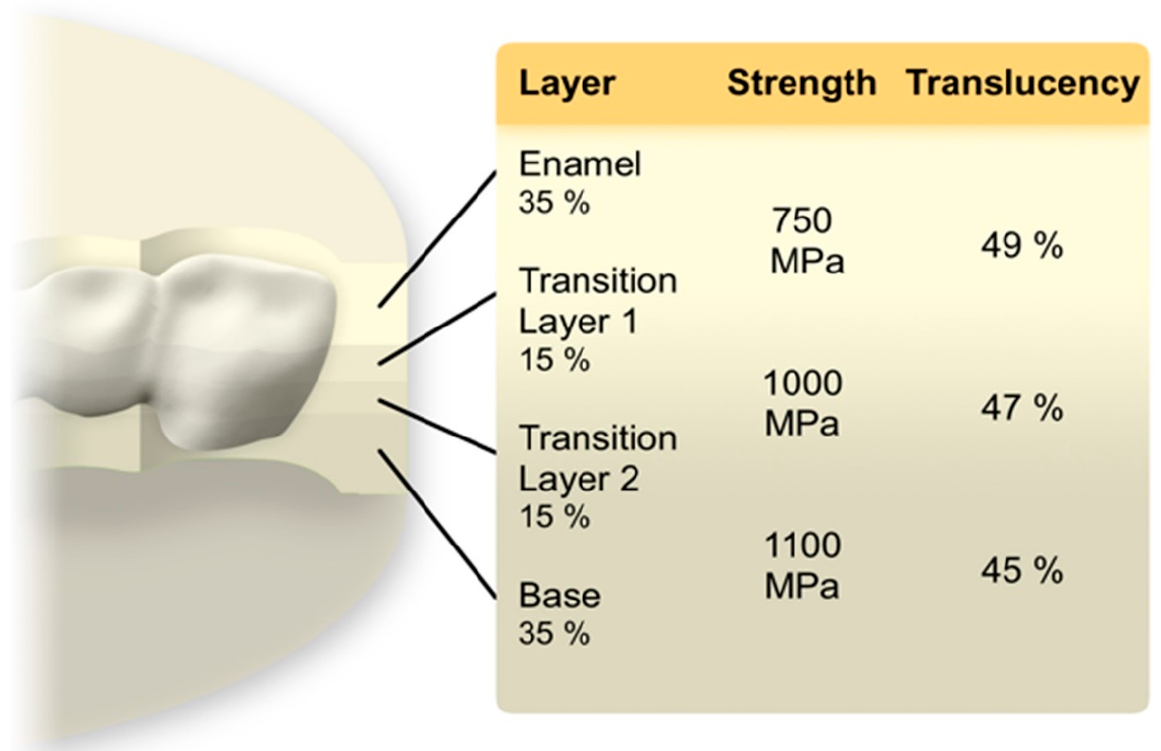
Figure 1. Multilayer architecture of a YML zirconia blank and nesting position. Data regarding the layer thickness, strength and translucency values was supplied by the manufacturer Kuraray Noritake.